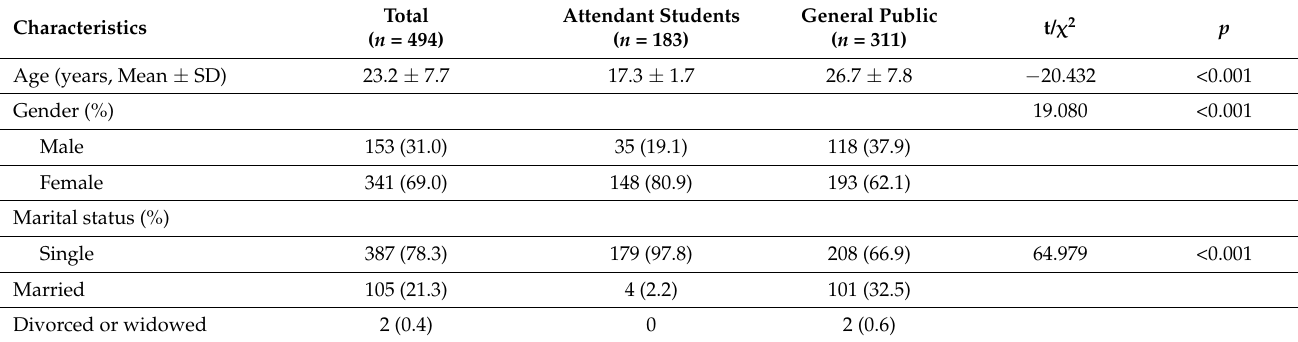
Table 1. Demographic characteristics of participants in this